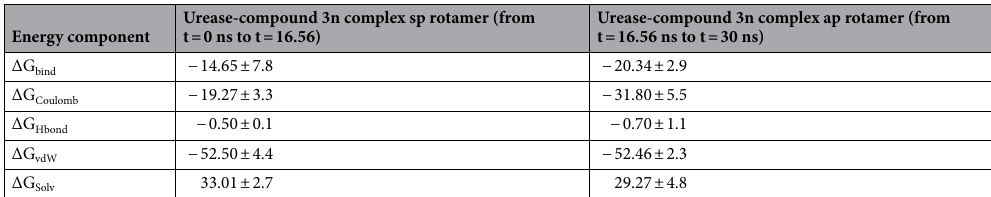
Table 4. Binding free energies and the individual energy terms of urease-compound 3n complex during the first 16.56 ns (0–16.56 ns) and the rest of the simulation time (16.56–30 ns) (kcal/mol). All energies are averaged over 100 snapshots and are given in kcal/mol.